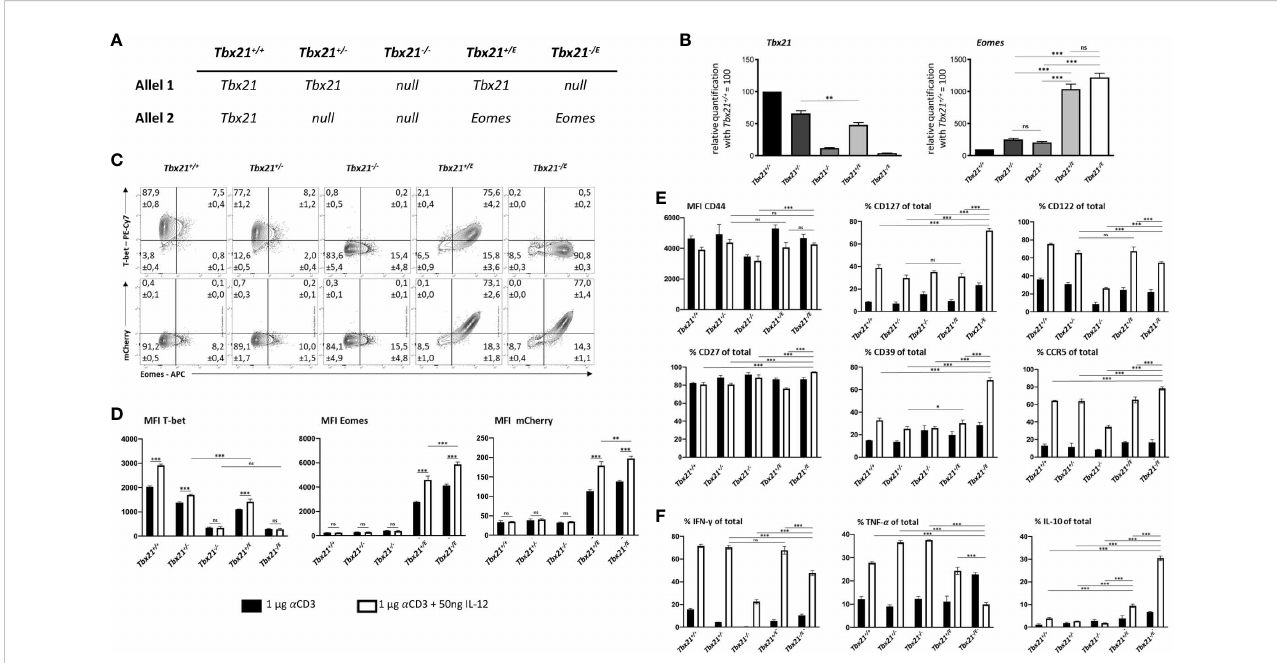
FIGURE 1 Eomes induces IL-10 production in CD4 + T cells in vitro. In vitro stimulation of splenocytes with soluble Anti-CD3 with or without IL-12 for 48 hours, cells were analyzed by RT-qPCR (B) or fl ow cytometry (C-F) . (A) Table of Tbx21 alleles corresponding to genotypes with + = Tbx21 (encoding for T-bet), E = Eomes , - = null allele. (B) RT-qPCR of Tbx21 and Eomes in relation to house-keeping genes GAPDH and HPRT after stimulation with Anti-CD3 and IL-12. Indicated genotypes were further normalized to Tbx21 +/+ (wild type), set as 100. (C) Intranuclear staining of T-bet and Eomes after stimulation with anti-CD3 and IL-12. Representative Dot plots are shown. (D) Mean fl uorescence intensities (MFI) of T-bet, Eomes and mCherry. (E) Surface staining for CD44 and intracellular staining (F) for TNF, IFN- g and IL-10 after 4 hours of stimulation with PMA, Ionomycin and Brefeldin (A) Statistical analysis: *=p < 0.05; **=p < 0.01; ***=p < 0.001; ns, not signi fi cant; Error bars denote mean + SEM.